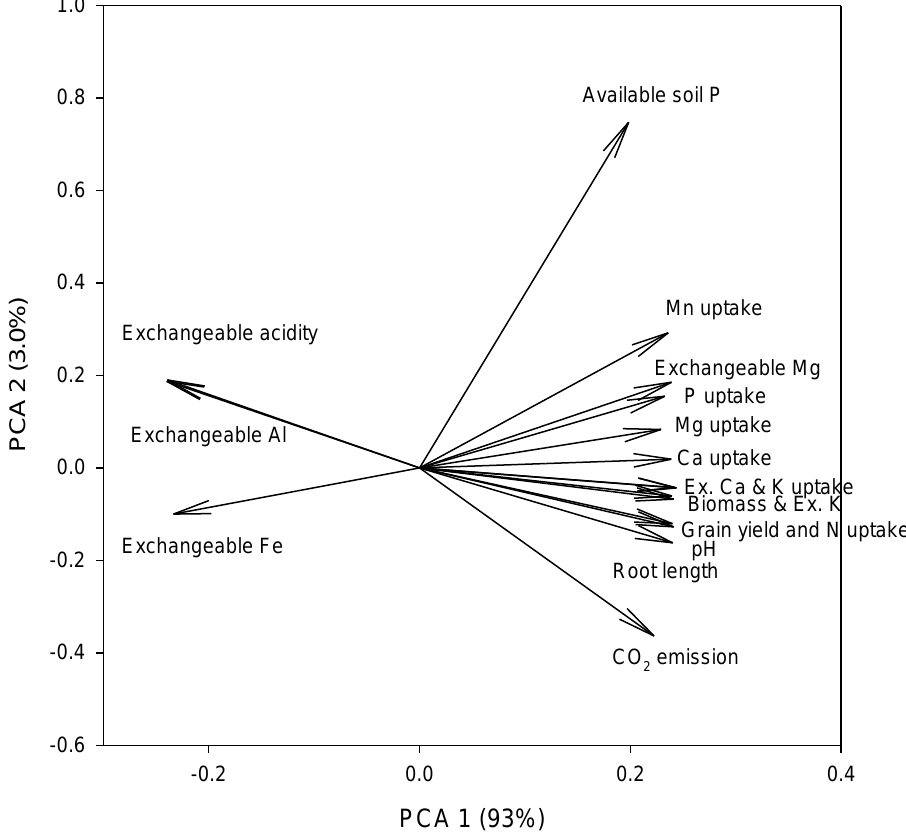
Figure 5. Principal component analysis of different variables.